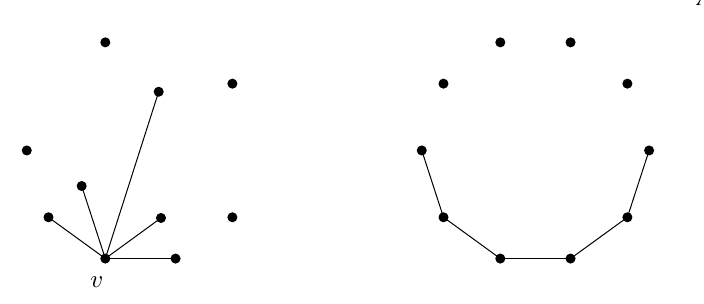
Fig. 1: Removing n edges from the complete geometric graph on a set of 2 n points can disallow a non-crossing perfect